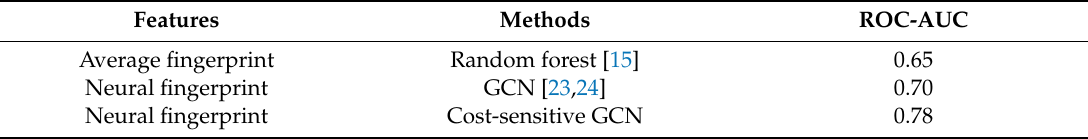
Table 4. The ROC-AUC performance of the model compared with state-of-the-art methods.